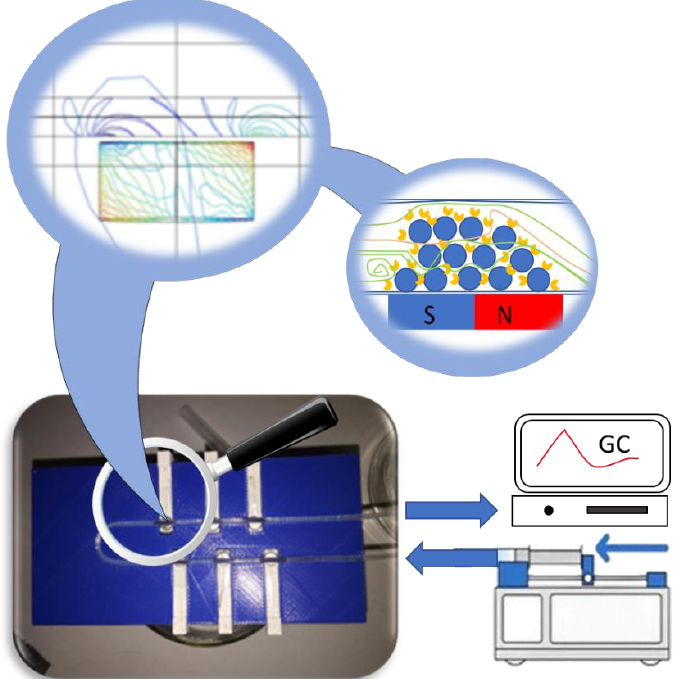
Figure 4. A simple U-shape MNP microreactor holding six adjustable permanent magnets under the PTFE tube reactor body. The MNP tube microreactor holder was created by 3D printing. The first excerpt shows the modeled magnetic field distribution within the empty tube. The second excerpt illustrates an idealized packing of the magnetically retained CaLB-MNPs.